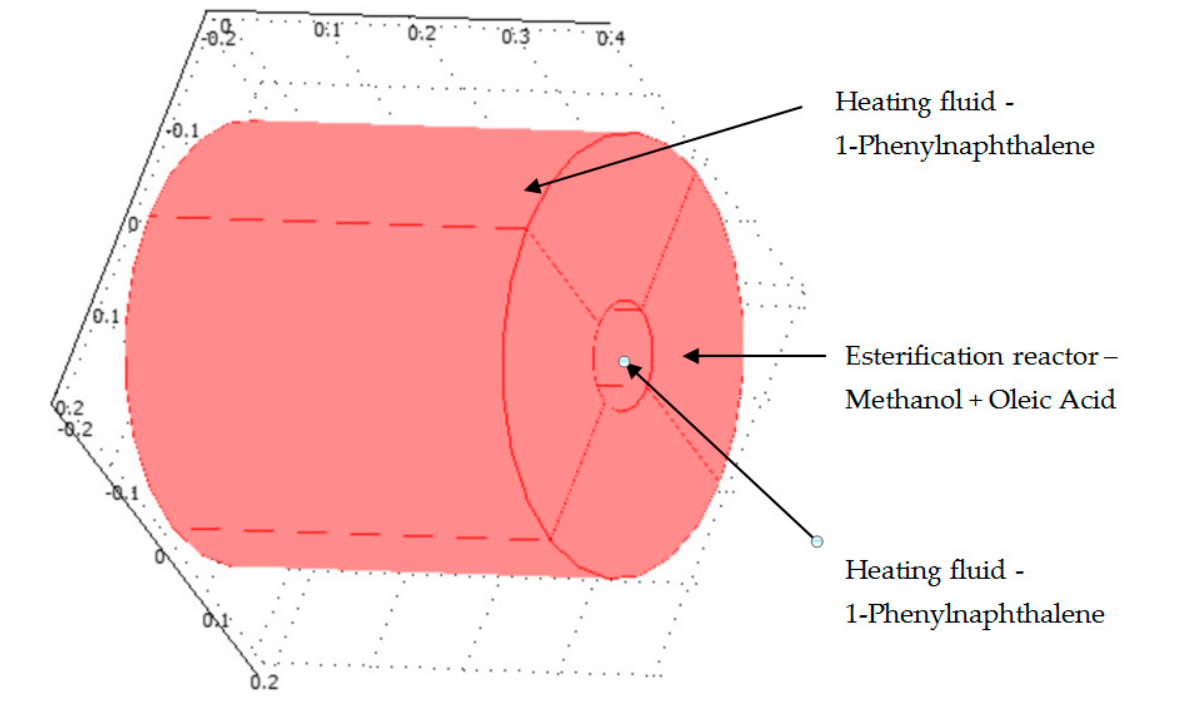
Figure 3. 3D plot of esterification reactor.